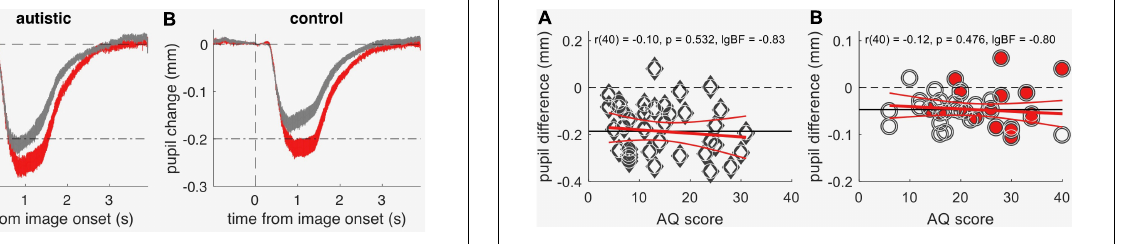
FIGURE 4 | Timecourses of pupillary constriction (referenced to pre-stimulus baseline) evoked by sun and phase-scrambled sun images (“scrambled”), in the group of autistic children (A) and in the comparison group (B) ; thin lines straddling the timecourse give s.e.m. at each timepoint. The dash-dot lines serve as reference to highlight the difference in response amplitude across panels.